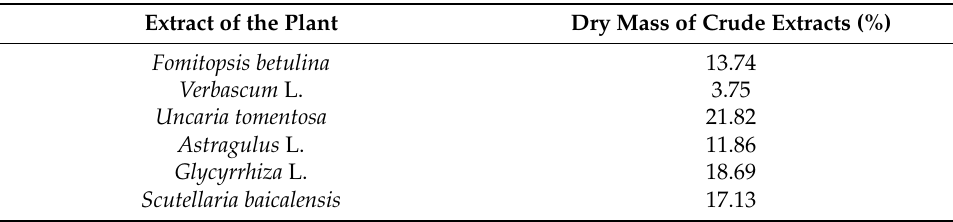
Table 1. Dry mass of plant